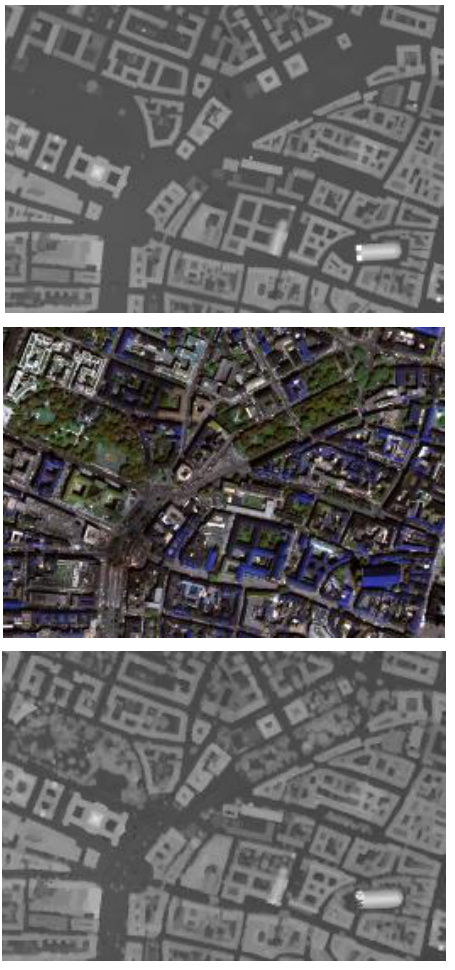
Figure 2.Flowchart of the proposed method